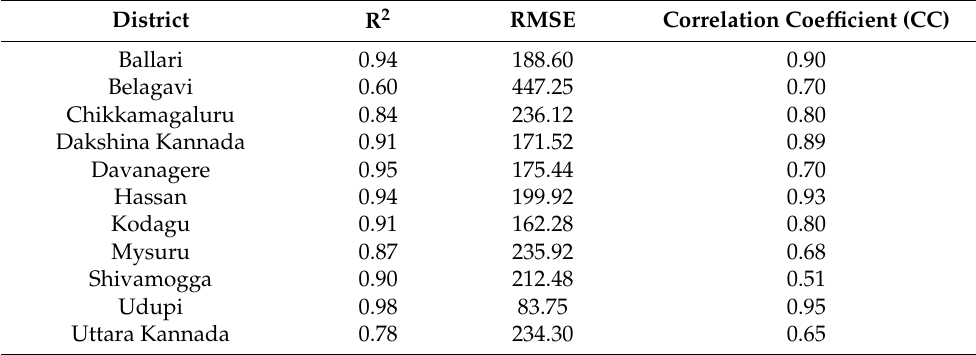
Table 6. Statistical evaluation of kharif rice yield using stepwise